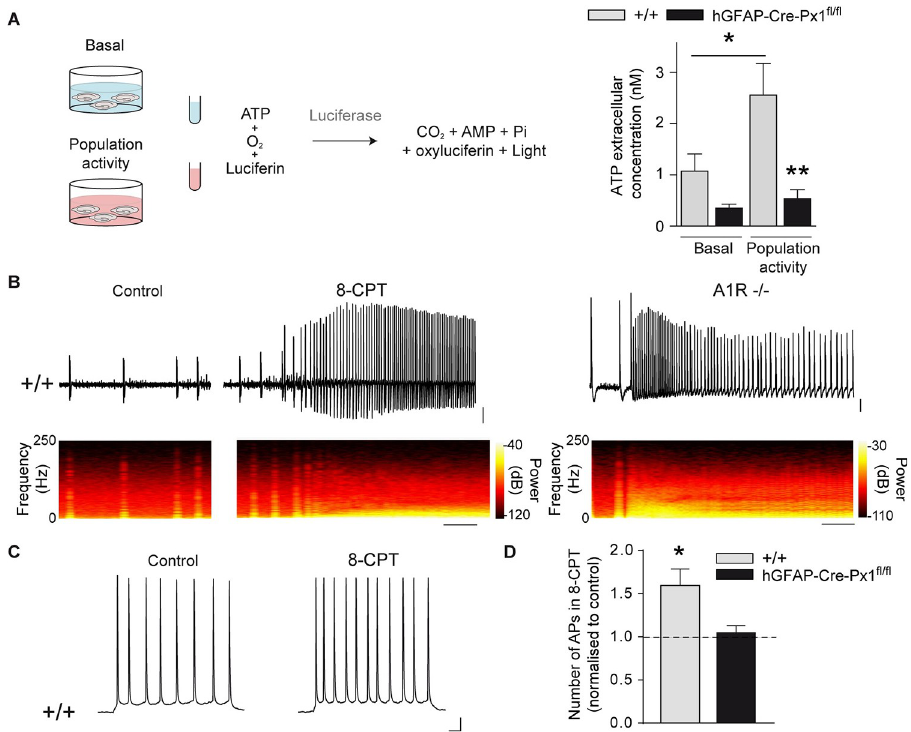
Fig 5. A1R signalling mediates the astroglial Px1 regulation of network activity and excitability. ( A ) Schematic diagram of the experimental design used to measure extracellular ATP concentration (left panel) and quantification of extracellular ATP concentration in 500 μ l of ACSF in basal and population activity conditions (+/+: Basal, n = 7 mice, Population activity, n = 6 mice; hGFAP-Cre-Px1 fl/fl : Basal, n = 8 mice, Population activity, n = 8 mice; right panel; one- way ANOVA and Bonferroni post hoc test). ( B ) Representative traces of neuronal network activity in +/+ mice before and during application of the A1R antagonist 8-CPT (1 μ M; n = 9 slices from 3 mice; scale bar, 20 s, 50 μ V) and in A1R − / − mice ( n = 10 slices from 3 mice; scale bar, 10 s, 100 μ V). The corresponding time-frequency plots are shown under the traces. ( C ) Representative traces of CA1 pyramidal cell firing pattern from +/+ and hGFAP-Cre-Px1 fl/fl mice in condition of population activity before and after application of 8-CPT during depolarisation by 10 pA injection for 500 ms. Scale bar: 50 ms, 10 mV. ( D ) Number of APs induced by 10 pA current injection, after application of the A1R antagonist 8-CPT, normalised to control (+/+, n = 7 neurons from 6 mice; hGFAP-Cre-Px1 fl/fl , n = 7 neurons from 3 mice; Student t test). Asterisks indicate statistical significance ( � p < 0.05). The data underlying this figure can be found in the S1 Metadata E